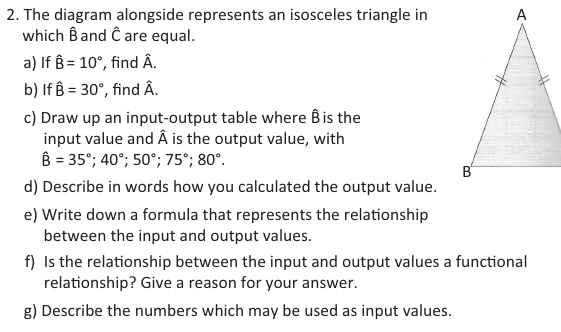
a gleich lange Schenkel Basis-Winkel b